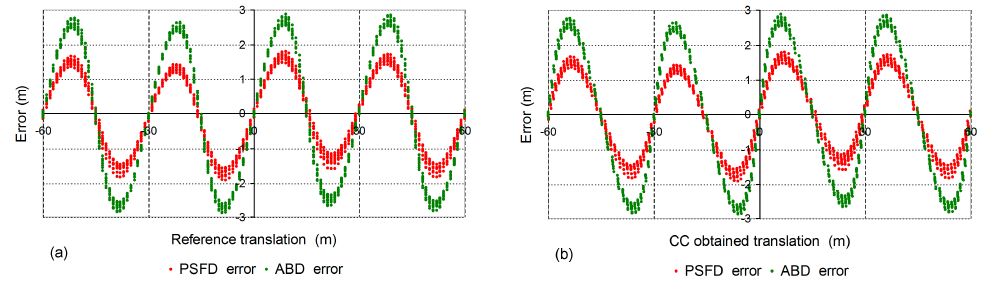
Figure 9. ( a ) The obtained errors versus the actual applied translations ( T IN ). Several results for each T IN are plotted from different band combinations applying CC. ( b ) The errors versus the translations ( T OUT ). In red and green are the errors associated with the PSFD and ABD image sets, respectively. The high number of results obtained along the sub-pixel reference translations allows for the analysis of the intra-pixel behavior of the errors (Figure 9). This also shows how these errors cannot be treated stochastically, in terms of standard deviation.